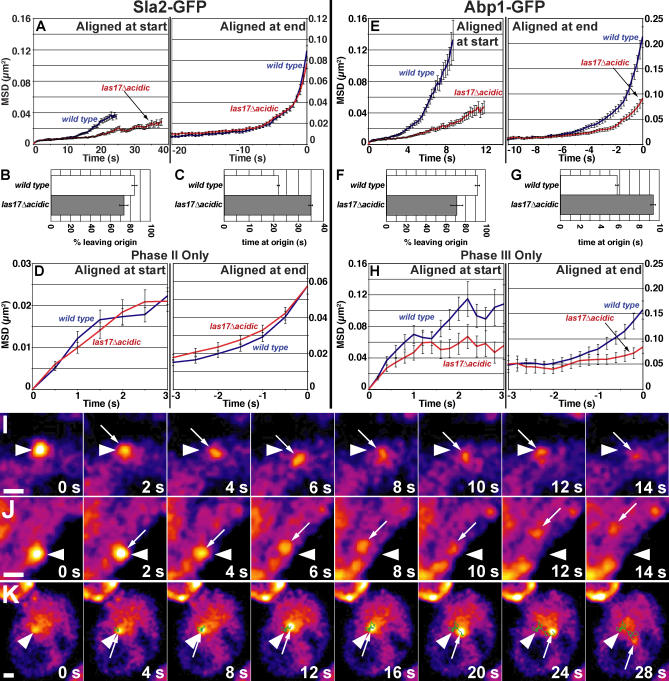
Quantitative Motion Analysis of las17Δacidic Patches and the Movement of GFP-WASp/Las17 ParticlesCells express Sla2-GFP (A–D), Abp1-GFP (E–H), or GFP-Las17 (I–K).(A) MSD plots for wild-type and mutant patches aligned at the start (left) or end (right) of their lifetimes. The curves on the left are truncated at the median lifetime.(B) Percentage of patches that leave the origin. Mean of values for three segregants is shown.(C) Average time at the origin, from the appearance of a patch until it moved away or disappeared.(D) Phase II movement only. For each patch, data prior to movement were removed.(E) MSD plots for wild-type and mutant patches aligned at the start (left) or end (right) of their lifetimes. On the left, plots are truncated at the median lifetime.(F) Percentage of patches that leave the origin, as in (B).(G) Average time at the origin, as in (C).(H) Phase III movement only. For each patch, data prior to the time the patch traveled 200 nm were removed. Only patches that moved at least 200 nm are included.(I–K) Time-lapse fluorescence images at the indicated intervals. Arrowheads indicate the position of the particle at time zero, and arrows follow the position of the particle over time. (I and J) Particles, presumably actin patches, appear at the cortex and move away. (K) A GFP-WASp/Las17 particle moving inside the cell. The path taken by the particle from time zero is overlaid in green. Scale bars, 500 nm.Strain numbers and the number of patches were as follows: (A–C) Wild-type, YJC5234–6; 106, 93, and 108, respectively. las17Δacidic, YJC5231–3; 100, 83, and 73. (D) Strains as in (A–C). Numbers of patches: wild-type – 88, 74, 90. las17Δacidic – 66, 67, 53. (E–G) Wild-type, YJC5214–6; 85, 86, and 98 respectively. las17Δacidic, YJC5208–10; 95, 76, and 89. (H) Strains as in (E–G). Numbers of patches: wild-type – 76, 69, and 84; las17Δacidic – 45, 43, and 49. Error bars are ± standard error. (I–J) YJC5736–7.